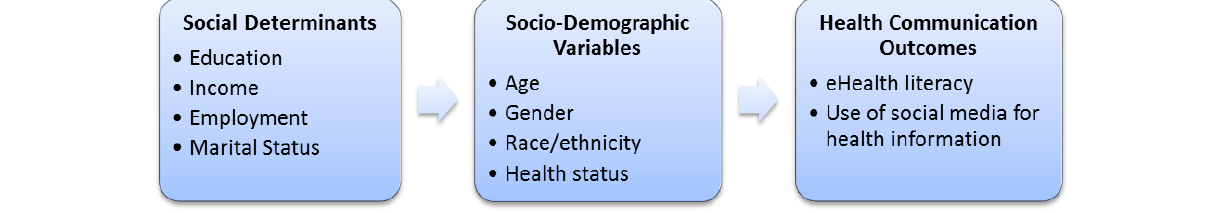
Figure 2. Adapted Structural Influence Model of Health